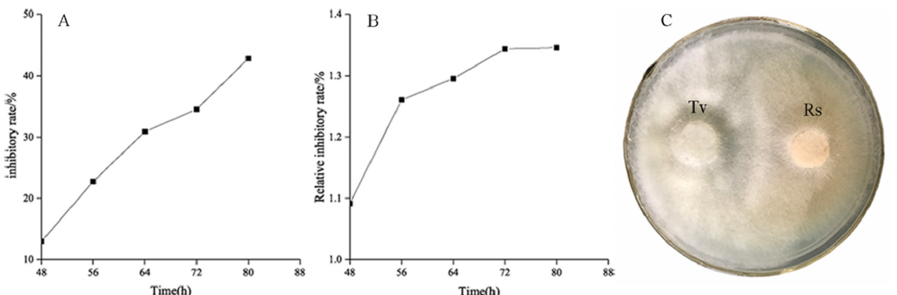
Figure 1. Antagonistic e ff ect of T. virens ZT05 against R. solani (( A ), inhibition rate of T. virens ZT05 against R. solani ; ( B ), relative inhibition e ff ect of T. virens ZT05 against R. solani ; ( C ), dural culture of virens ZT05 and R. solani ; Tv, T. virens ZT05; Rs, R. solani ). T. virens ZT05 and R. solani ; Tv, T. virens ZT05; Rs, R. solani